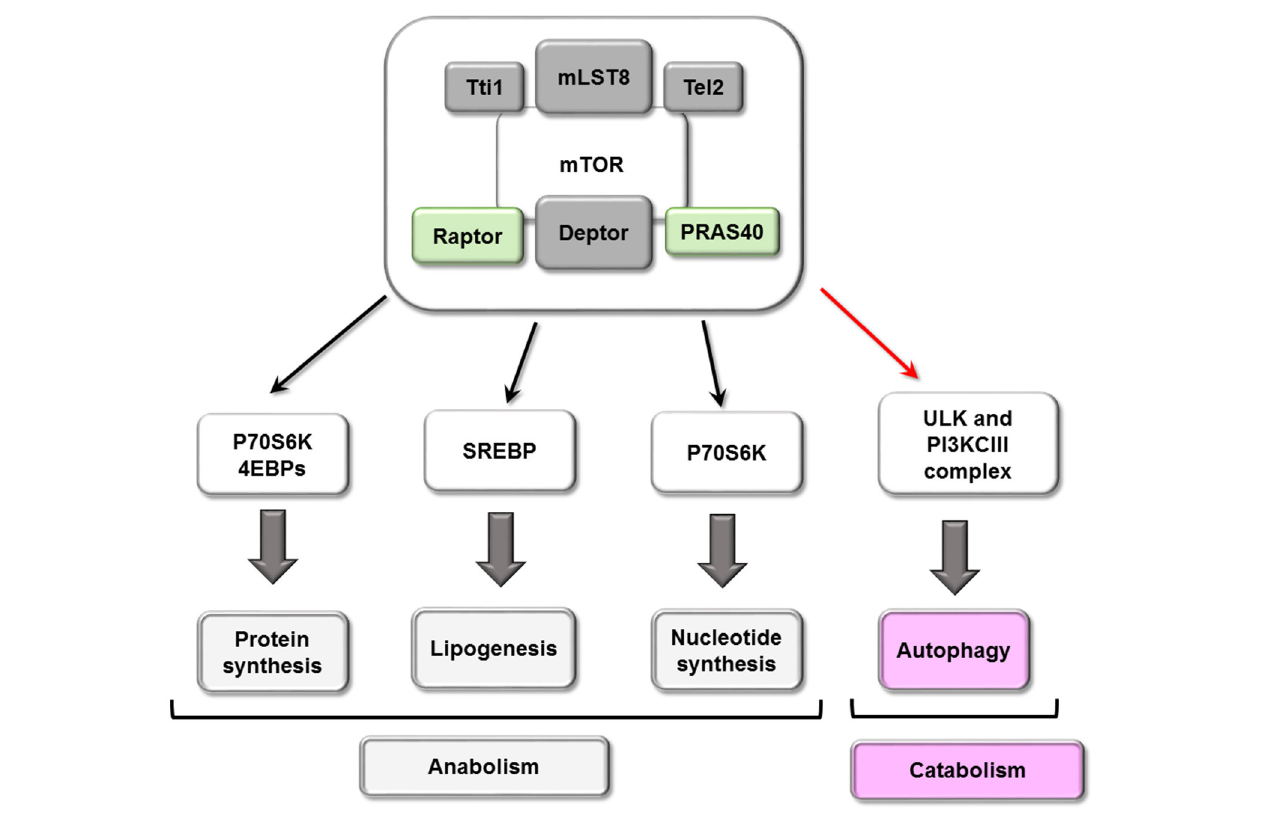
FIGURE 4 | Cellular processes mTORC1 mediated. mTORC1 play a central role in cellular metabolism controlling some anabolic (synthesis of proteins and nucleotide, lipogenesis) and catabolic (autophagy)